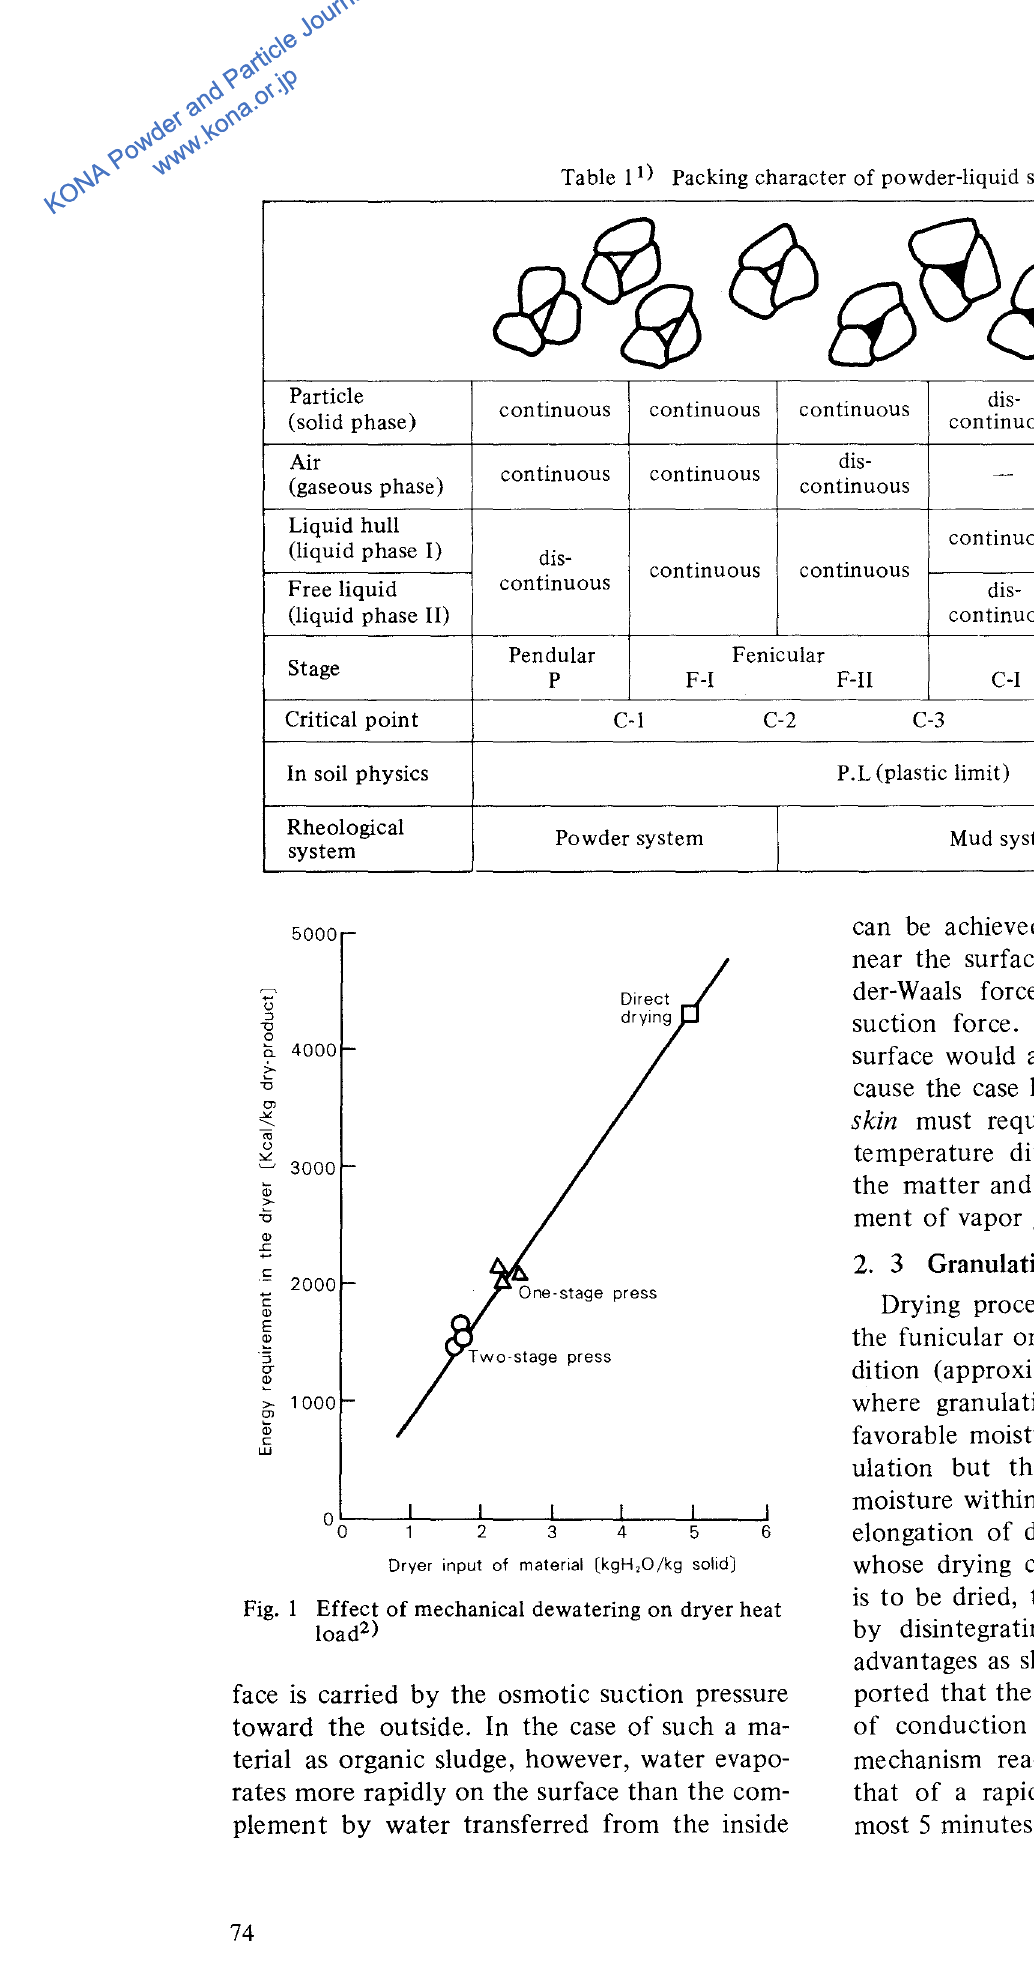
Table J 1) Packing character of powder-liquid systems